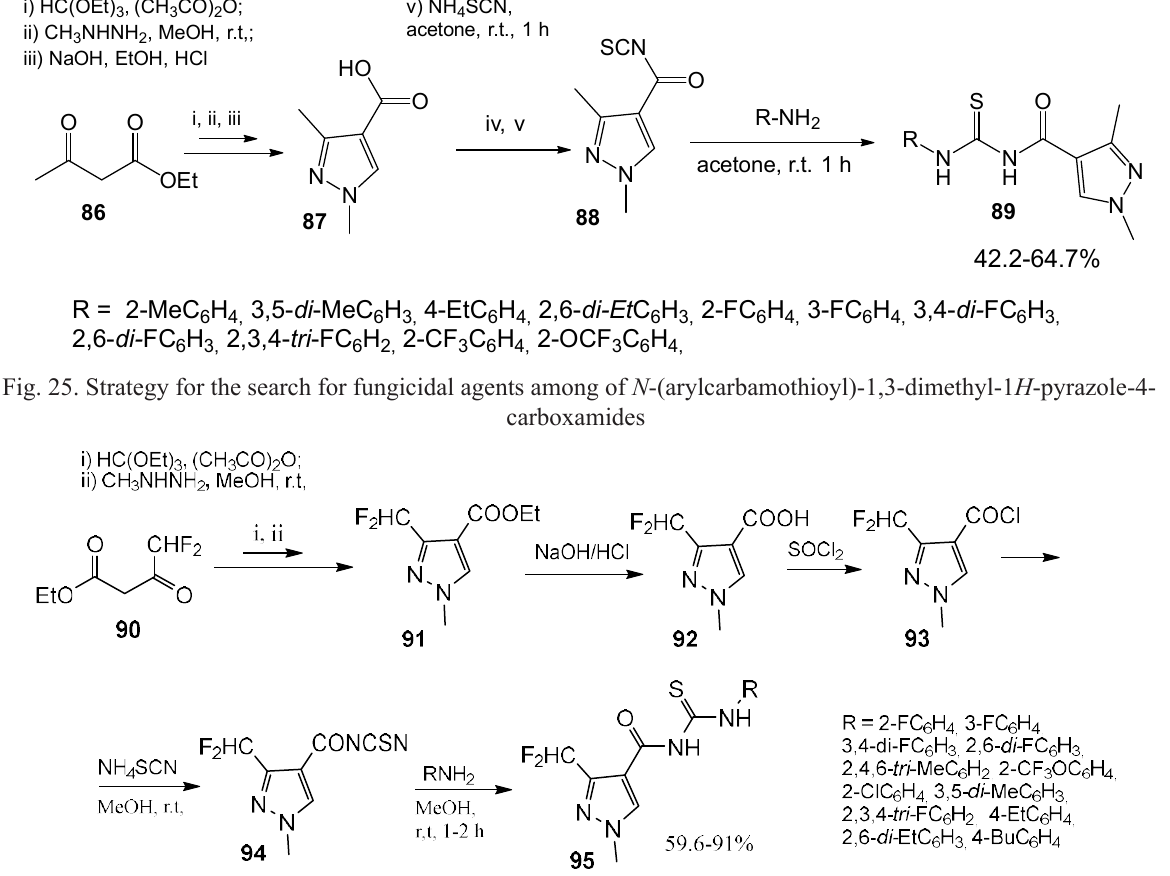
Fig. 26. Strategy for the search for fungicidal agents among of 3-(difluoromethyl)-1-methyl- N -(arylcarbamothioyl)-1 H -